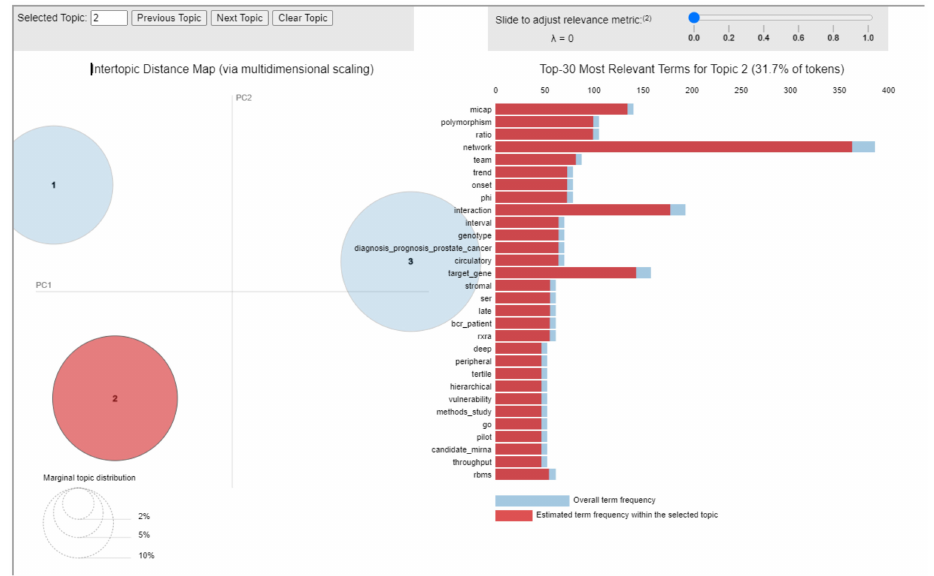
Figure 6. Inter-topic Distance Map related to the topic 2. Circle 1 indicates topic 1, circle 2 is topic 2 and circle 3 is topic